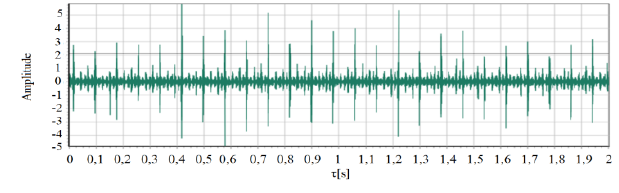
Fig. 8. A fragment of the registered phase-to-phase voltage waveform as a function of time: 1 – waveform obtained from measurements, 2 – refe- rence